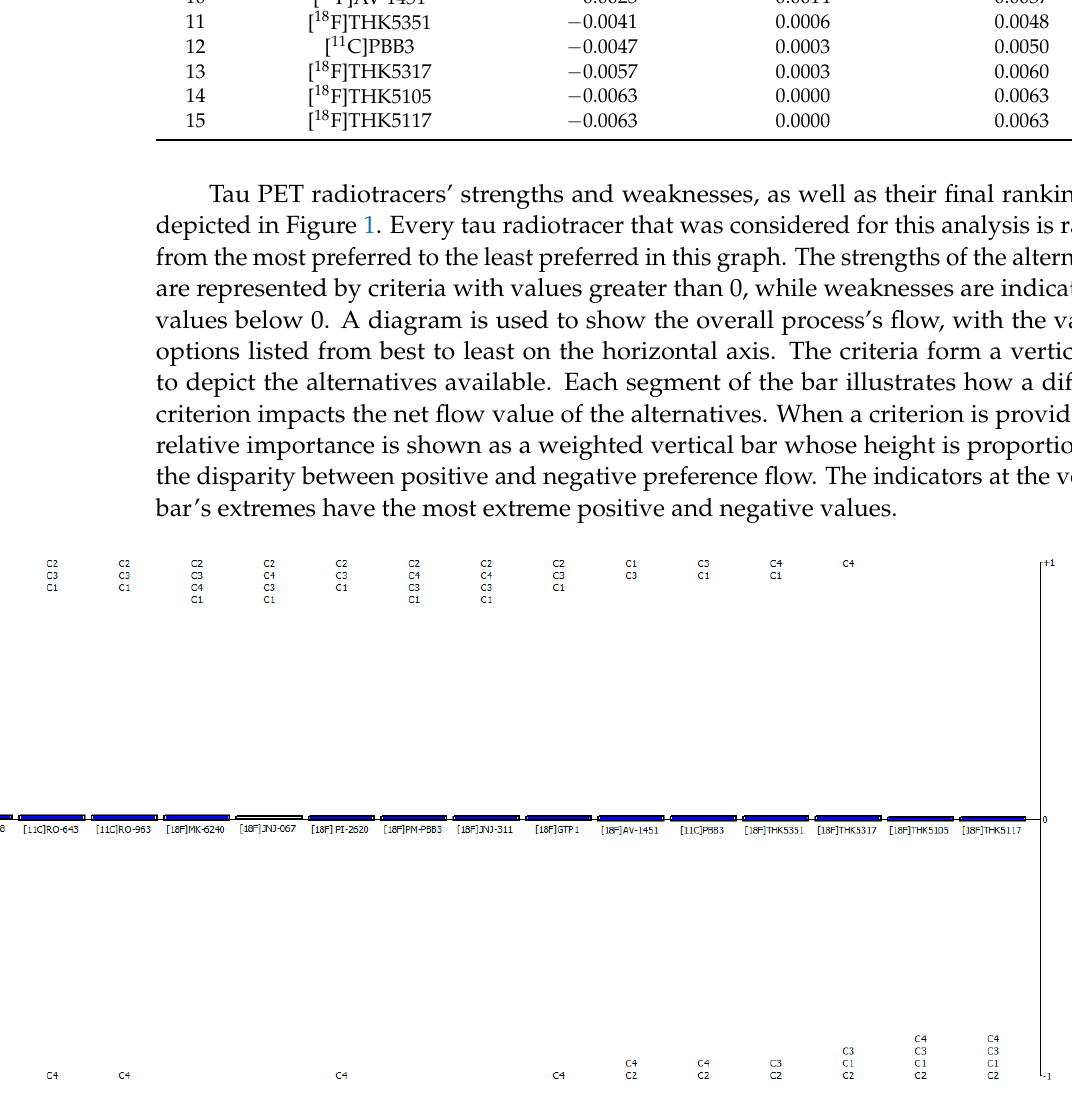
[ 18 F]GTP1 0.0013 0.0020 0.0007 10 [ 18 F]AV-1451 − 0.0023 0.0014 0.0037 11 [ 18 F]THK5351 − 0.0041 0.0006